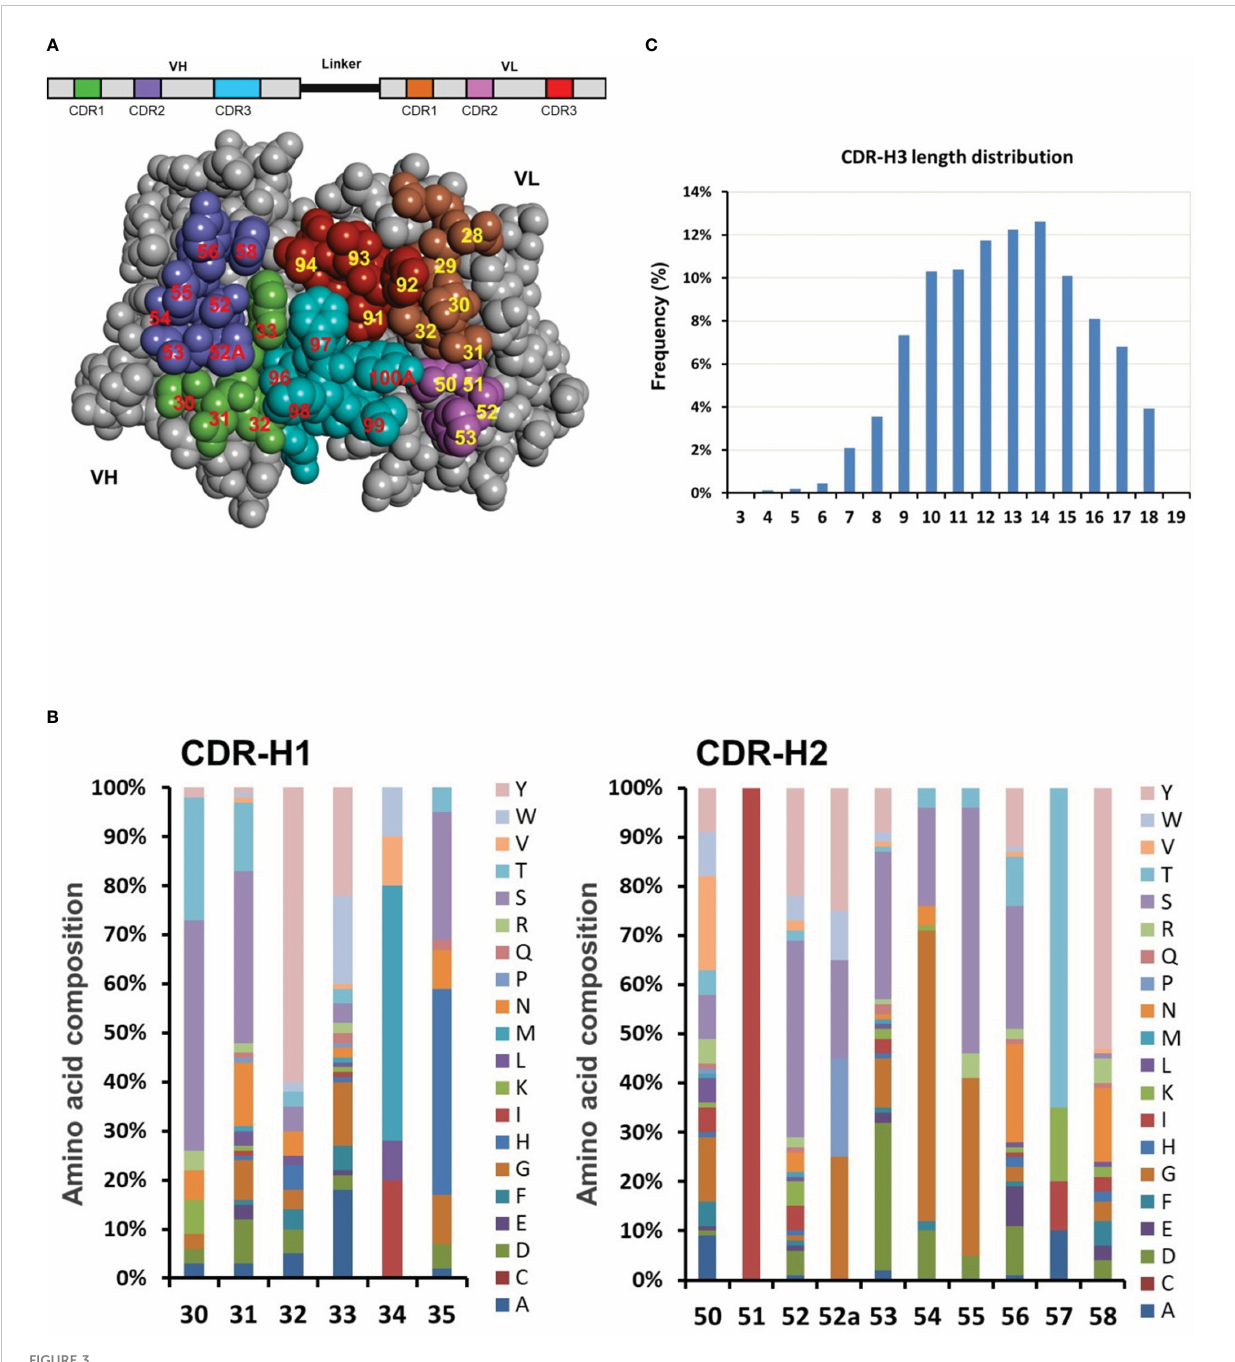
FIGURE 3 Dsyn-1 library design. (A) The library is based on the VH-linker-VL (scFv) format and the three-dimensional structure of VH and VL domains are shown as a space- fi lling model. The potential antigen contact residues in the CDRs chosen for diversi fi cation are colored green (CDR-H1), purple (CDR-H2), cyan (CDR-H3), brown (CDR-L1), pink (CDR-L2) or red (CDR-L3), and numbered according to the Kabat nomenclature. This Figure was generated with Discovery Studio Visualizer 2019 (Dassault Systèmes BIOVIA, San Diego) using coordinates for the crystal structure of free Fv4D5 (PDB entry 2FJF). (B) Engineered diversity of CDR-H1 and CDR-H2. The natural diversity was calculated from the alignment of thousands of antibody sequences from the DCB database for simulating six CDR variability. The designed percentage of each residue at each CDR position is schematically illustrated. (C) The designed CDR-H3 length distribution (Kabat ’ s de fi nition) is based on natural length